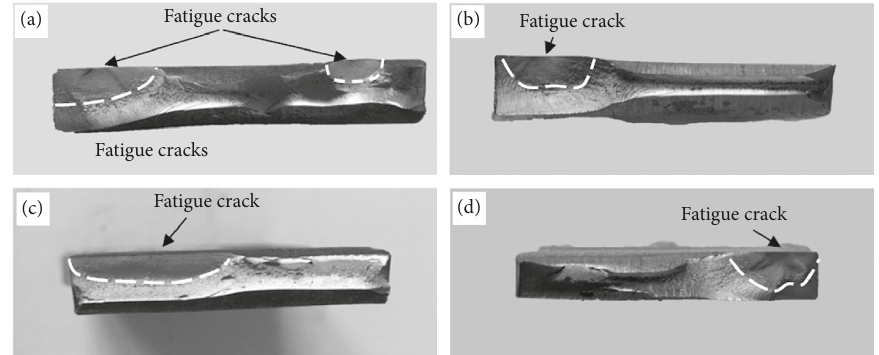
Figure 4: Typical macrofractures of the pipe body (a) without surface finishing and (b) with surface finishing and those of the weld joint (c) without surface finishing and (d) with surface